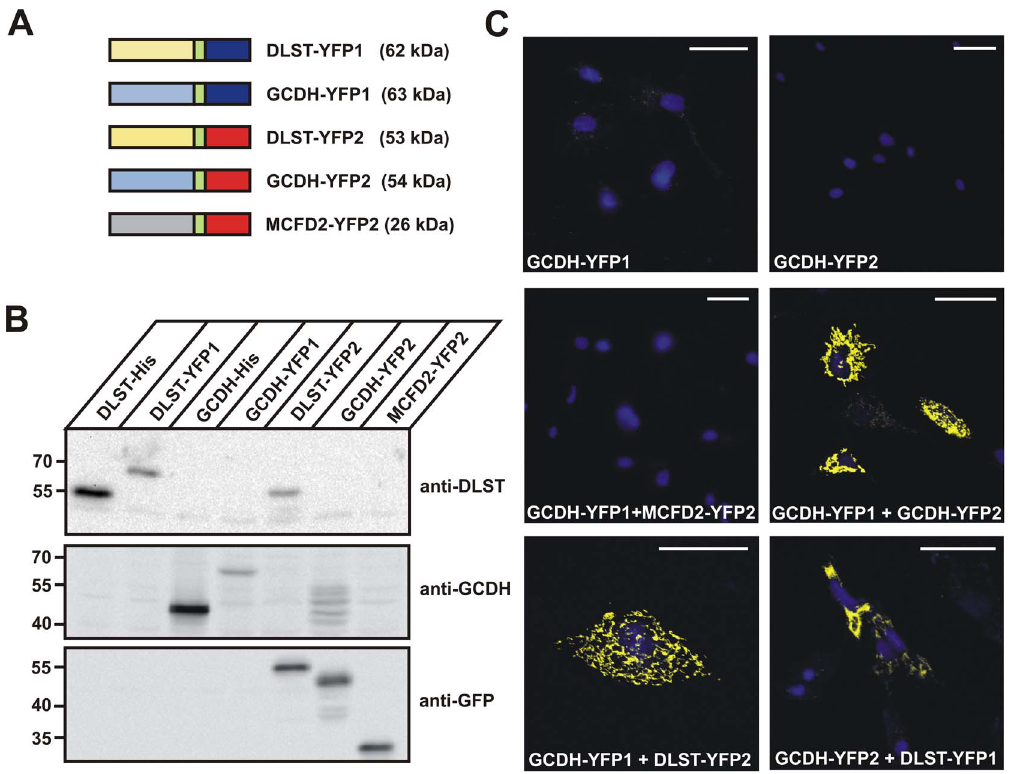
Figure 5. YFP fragment complementation assay demonstrates the interaction of GCDH with DLST invivo . ( A ) Schematic composition of C-terminal YFP1 (dark blue) and YFP2 (red) fusion proteins of DLST, GCDH and MCFD2 used in this study. The 10-amino acid linker (GGGGS) 2 is indicated in green. The calculated molecular masses of the fusion proteins are shown in brackets. The ERGIC marker protein MCFD2-YFP2 was used as negative control. ( B ) Expression analysis in BHK cells of all fusion proteins visualized by western blotting, using anti-DLST, anti-GCDH and anti-GFP antibodies. ( C ) Fluorescence microscopy of the indicated single or co-expressed fusion proteins. Strong YFP fluorescence was observed in cells co- expressing either GCDH-YFP1 with DLST-YFP2 or GCDH-YFP2 with DLST-YFP1. Nuclei were visualized using DAPI (blue). Scale bars=40 m M. Representative images of n=3 independent transfection experiments are shown.